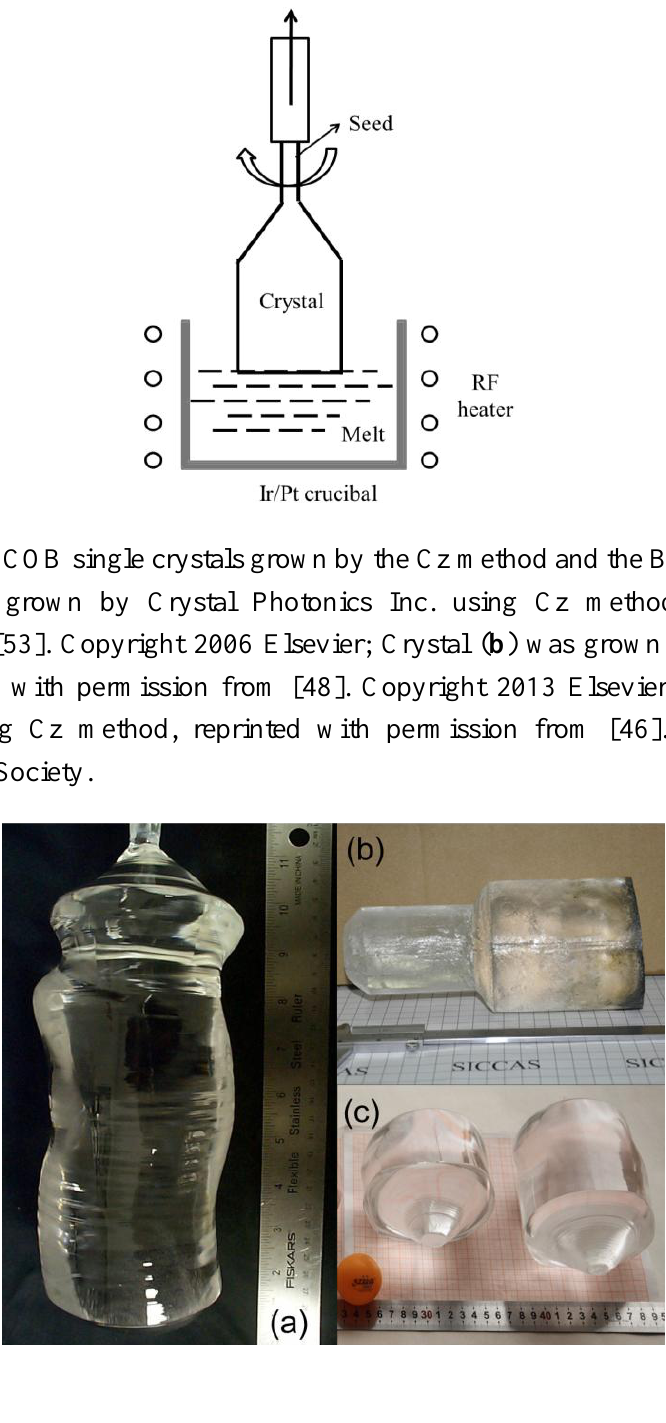
Figure 2. Schematic set-up of the Cz method for crystal